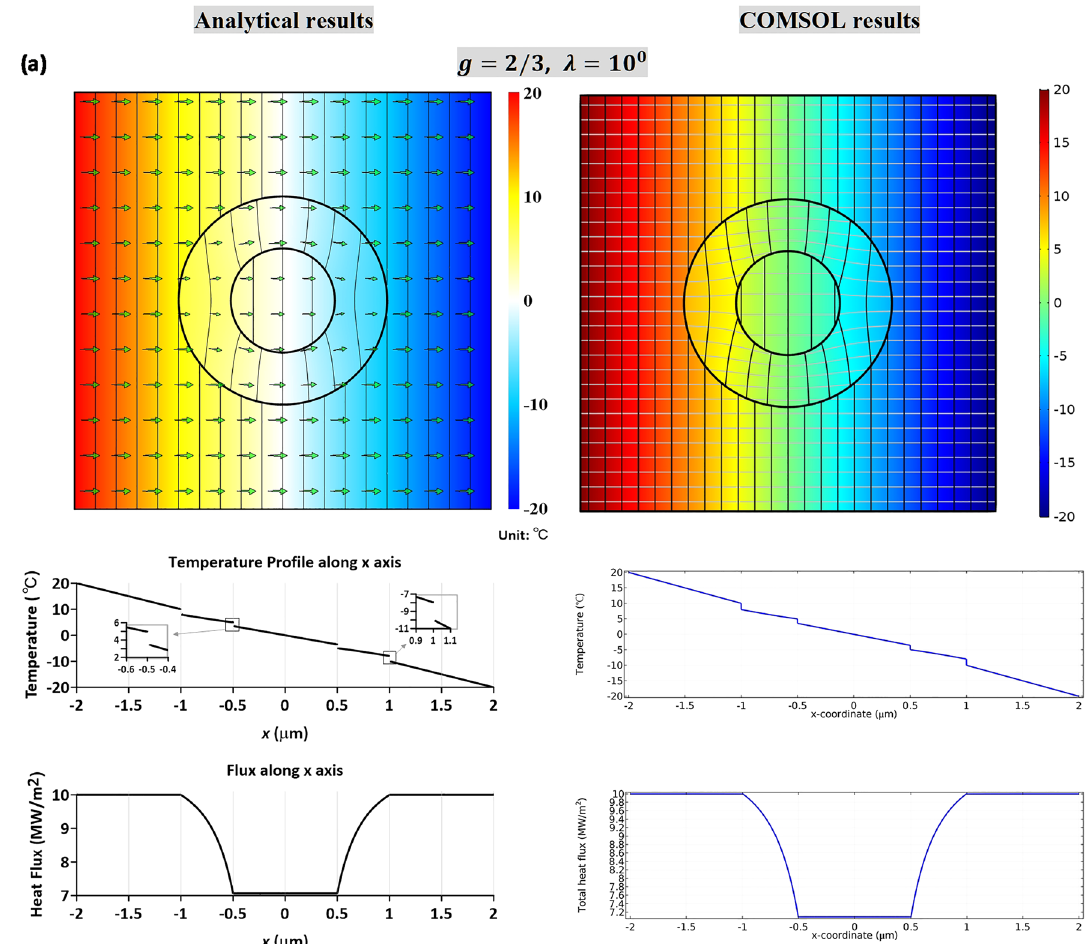
Figure 5. The temperature and heat flux profiles based on the analytical solutions, (6), (7), (9) and (10), and the numerical simulations based on finite element calculations (COMSOL). The left panel is the analytical solutions based on (6) and (7) for LC-type interfaces, and (9) and (10) for HC-type interfaces. The right panel is the numerical simulations based on finite element calculations (COMSOL). In numerical calculations, we consider c = 1/4 and b = 1 μm. For g = 2/3, LC-type interfaces are invoked. Temperature contours for λ = 10 0 is illustrated in ( a ). For g = 3/2, HC-type interfaces are necessary, and contour plots for λ = 10 0 are given in ( b ). A temperature or heat flux profile along the x -axis is shown below the contour diagram to highlight the jump of relevant quantity across the